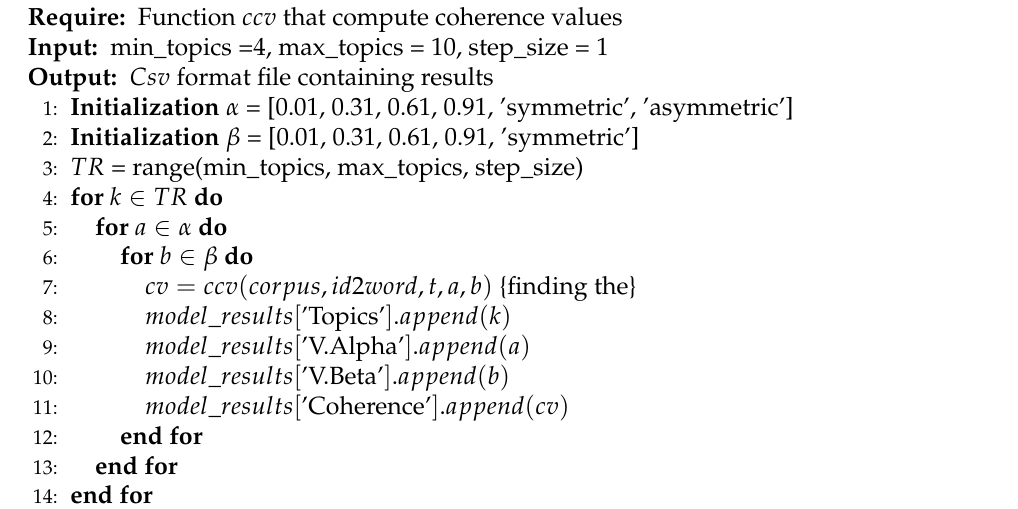
Figure 5. Intertopic distance map for k = 9 and k = 4. ( a ) 9 topics. ( b ) 4 topics. Algorithm 1 Algorithm to find the value of k that maximizes the coherence of an LDA model by testing different values of